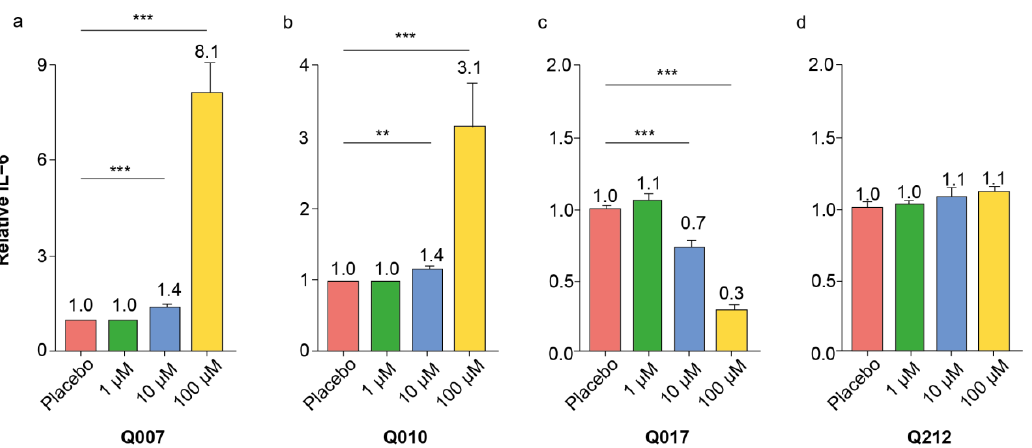
Figure 2. Results of IL-6 ELISA after 24 h incubation of splenocytes with different concentrations of QSP. ( a ) Q007; ( b ) Q010; ( c ) Q017 and ( d ) Q212. Bars and numbers on top represent means, with error bars representing s.e.m. Asterisks indicate the following criteria of statistical significance: * p ≤ 0.05 ** p ≤ 0.01 *** p ≤ 0.001 (two-sided t-test between placebo and specific QSP concentration).